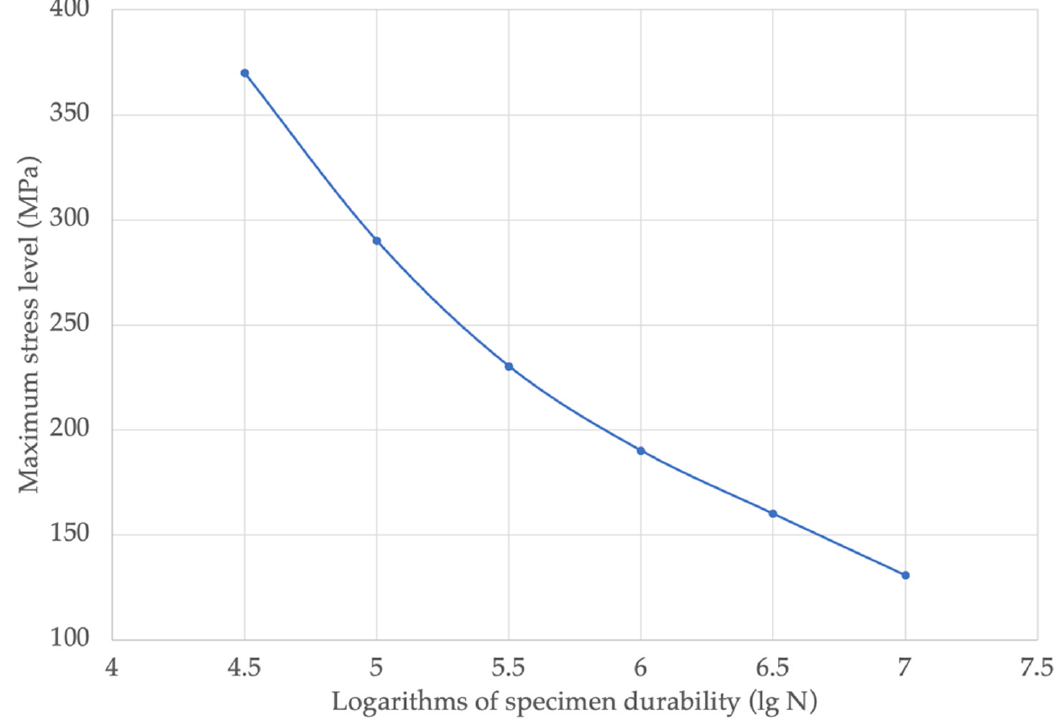
Figure 9. Calculated values of the fatigue curve of VT-14+Nb+Cu+12KH18N10T specimens obtained by diffusion welding with a fracture probability of 50%.